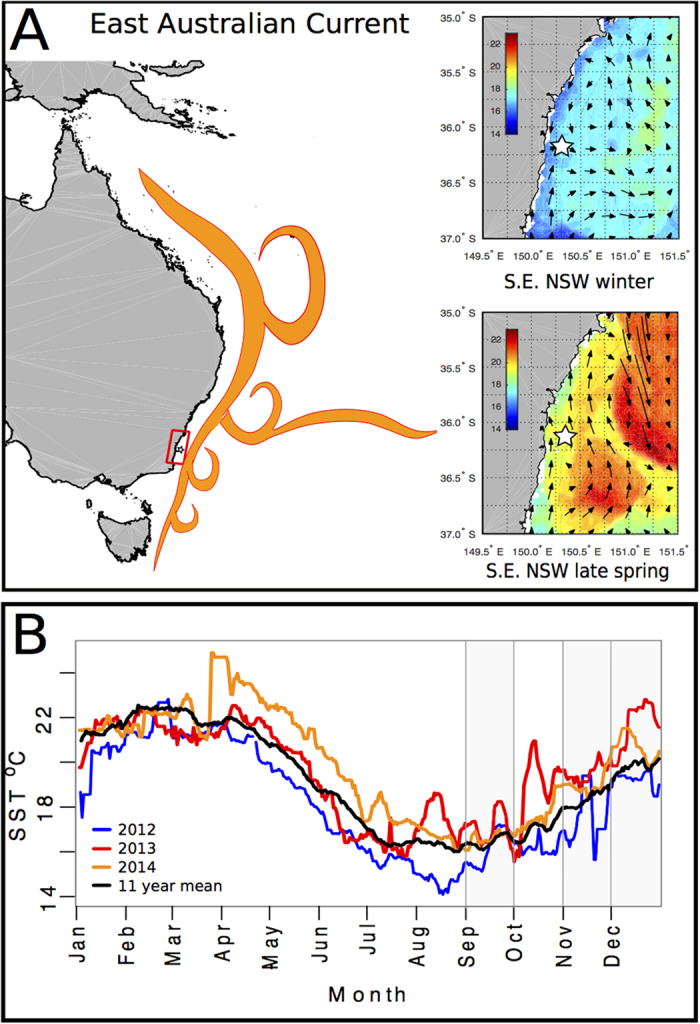
(A) Schematic showing the general characteristics of the East Australian Current (left). The area of this study (southeast NSW) is indicated by the red box, and the white star marks the location of Montague Island. On the right are examples of typical winter (top) and late spring (bottom) sea surface temperature and current directions in southeast NSW around Montague Island (white star). Inset maps were produced in MATLAB R2014b using data available from http://imos.aodn.org.au/imos/. (B) Annual time series of sea surface temperature measured offshore from Montague Island during 2012, 2013 and 2014 with a rolling 10-day mean. Grey windows represent the months (Sep, Nov, Dec) in which penguins were tracked from 2012–2014.